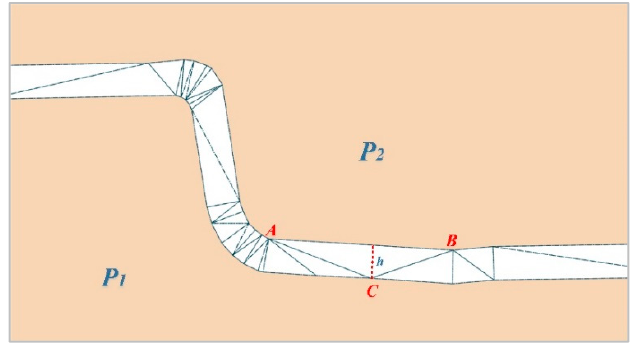
Figure 6. Height of a triangle between adjacent parcels.